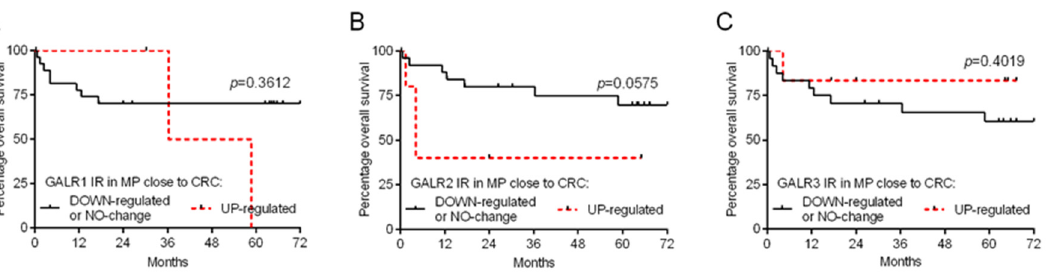
Figure 4. Kaplan–Meier diagrams that show the relative immunoexpression of galanin receptors (GALR1—( A ), GALR2—( B ), and GALR3—( C )) in myenteric plexuses (MP) regarding the overall survival of colorectal cancer (CRC) patients (n = 31). Table 1. Analysis of overall survival of CRC patients in relation to GALRs immunoexpression in